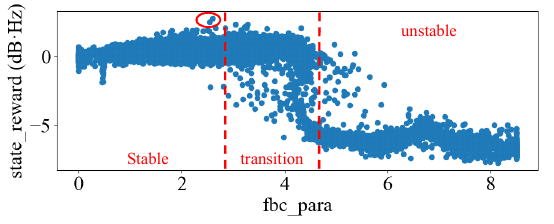
Figure 12. Scatter diagram of state reward and feedback proportional parameter. In Figure 13, the results of the multi-parameter self-learning experiment are shown when the initial proportional control parameters P of the FBC and FFC are both 0. From Figure 13a–f, the optimal parameter of FBC is in the range of [2.0, 3.0], and the FFC pa- rameter is located in [ − 5.0, − 4.0]. The results show that the parameters learned simultane- ously have good consistency with the values learned separately. Figure 14 is the 3D projected scatter diagram of state reward and the multiple param- eters. The red circles in the figure indicate the area where the optimal values are located, and the identification results are consistent with the final convergence values of the learn- ing curves. Due to the high-order, nonlinearity, and strong coupling characteristics of the actual system, its dynamic characteristics are very complex, and it is difficult to obtain ac- curate system control parameters. Nevertheless, the above experiments show that a small optimal value interval can be determined.